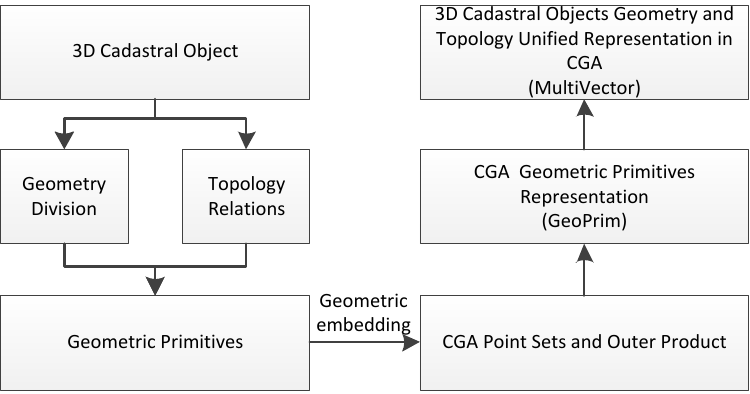
Figure 2. Processing flow of the CGA (conformal geometric algebra) -based 3D (three-dimensional) cadastral data model.